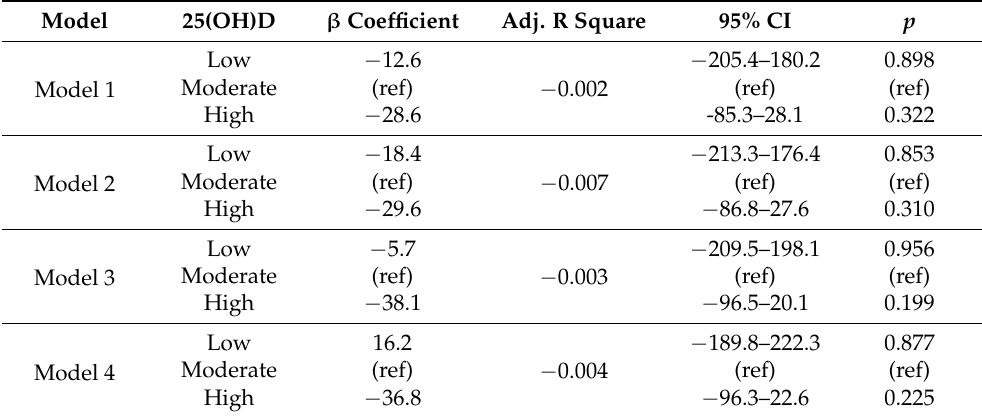
Table 7. Association between different 25(OH)D cut-offs and Telomere length by sex at 36 months.